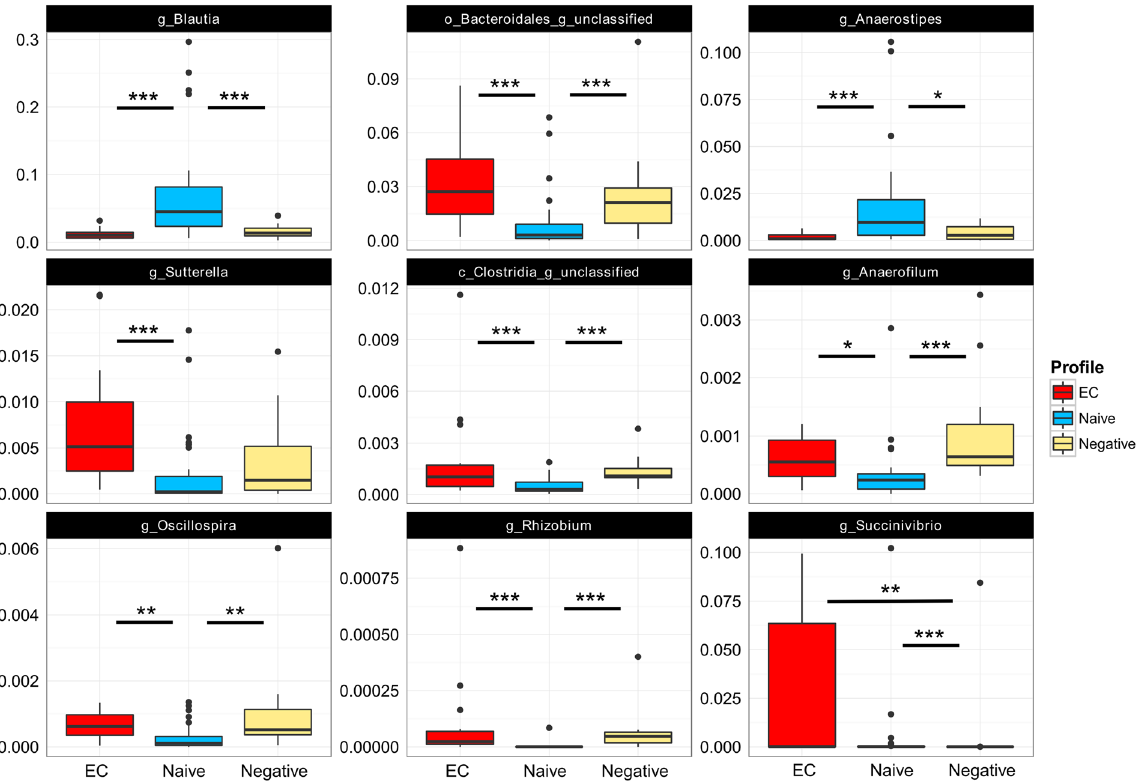
Figure 3. Compositional differences in fecal microbiota between groups. Several differences in bacterial abundance were observed between the groups at genus level. Comparisons of taxa abundances were performed via Kruskal -Wallis rank based test and Benjamini-Hochberg method was used for correction of multiple testing. Adjusted p-value < 0.01 was considered significant for Kruskal-Wallis. Dunn’s post-hoc pairwise analyses: * p < 0.05, ** p < 0.01, *** p < 0.001. Box plots represent median (black horizontal line), 25th and 75th quartiles (edge of boxes), upper and lower extremes (whiskers). Outliers are represented by a single data